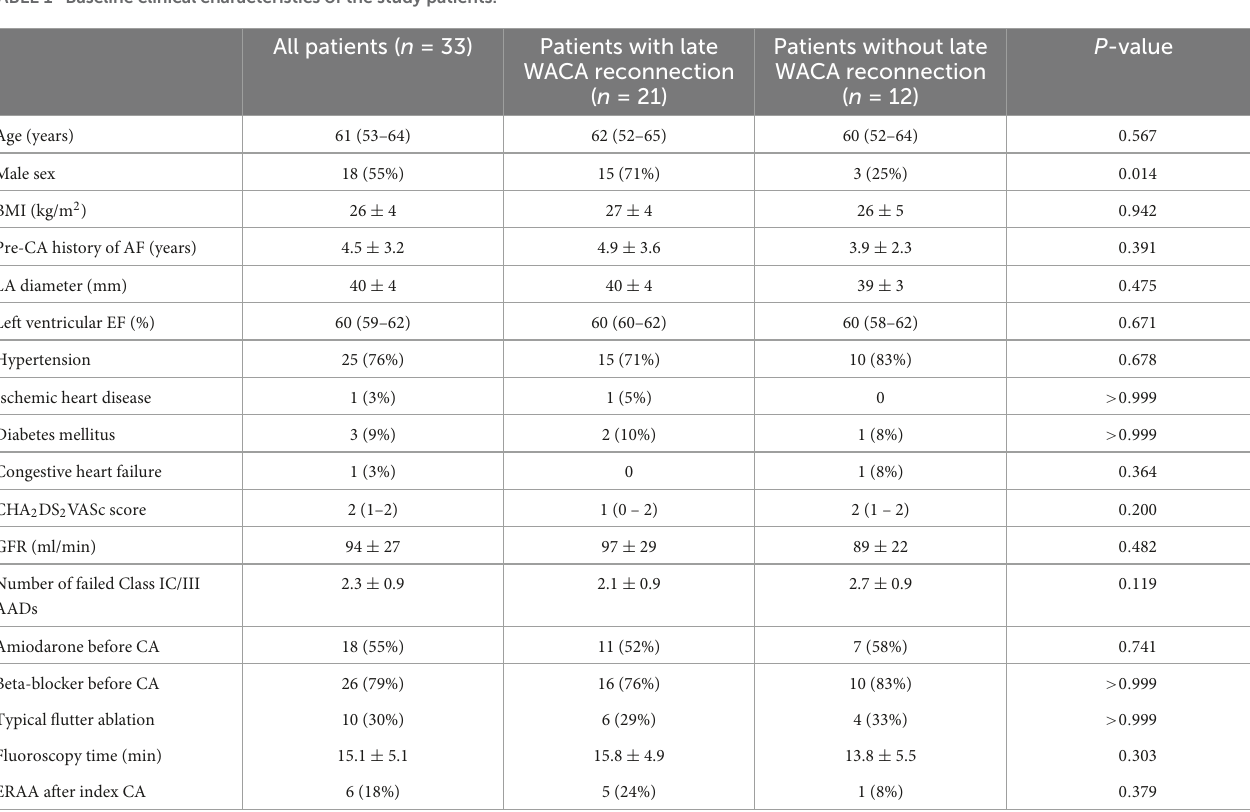
TABLE 1 Baseline clinical characteristics of the study patients. All patients ( n =